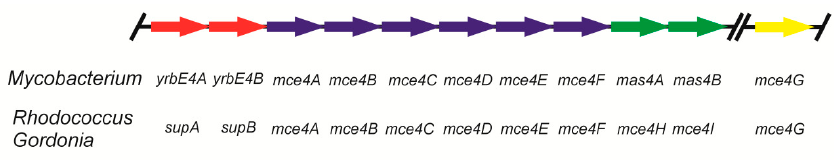
Figure 2. Genetic organisation of the mce4 cluster involved in sterol uptake in Actinobacteria.